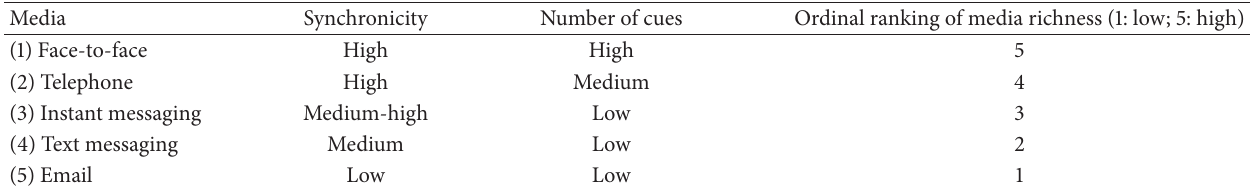
Table 1: Media richness of various